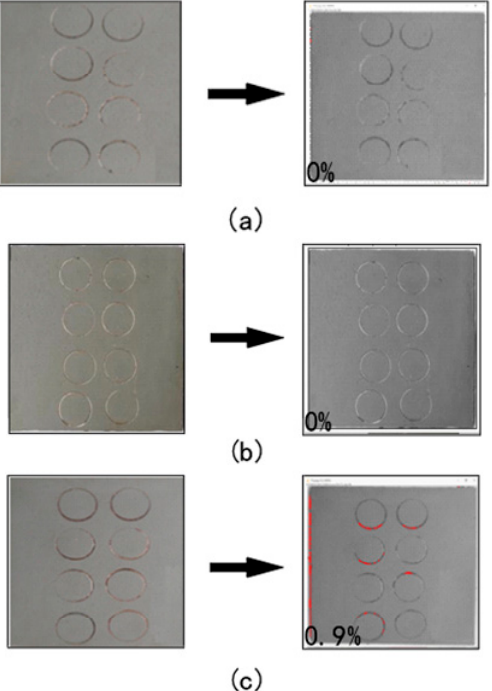
Figure 23. Corrosion of the with-zinc specimens after saltwater corrosion for ( a ) 0 days, ( b ) 14 days, and ( c ) 28 days (Note: the red area represents the corrosion area).